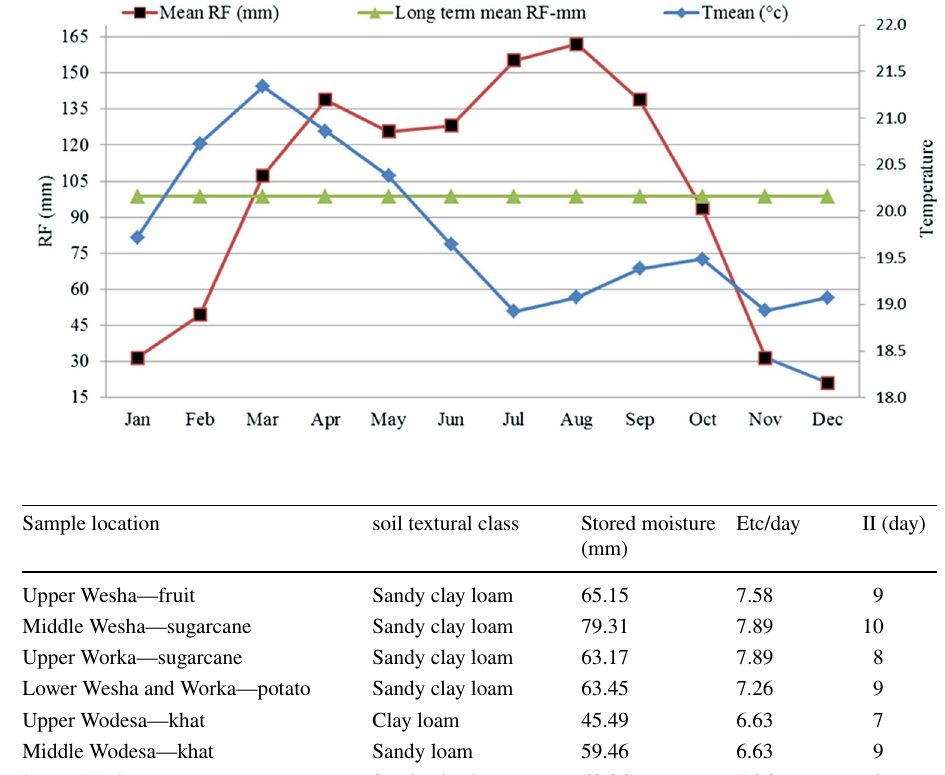
Fig. 5 Average monthly pre- cipitation and daily temperature at Wondo Genet Watershed